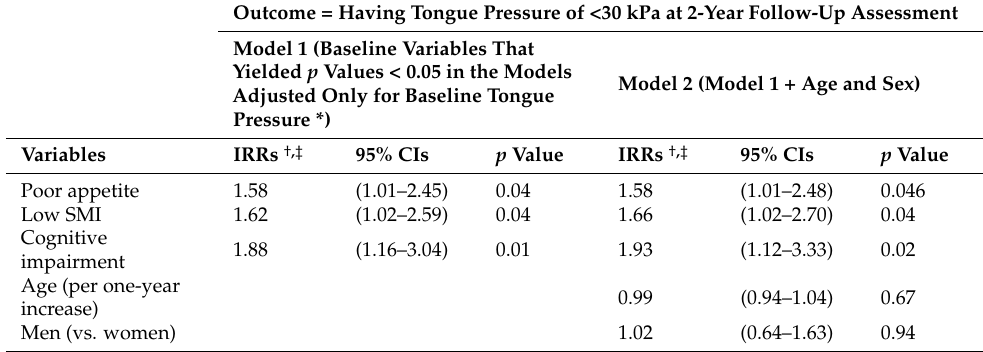
CI, confidence interval; IRR, incidence rate ratio; SMI, skeletal muscle mass index. * Candidate baseline variables are presented in Table 2. † Applying inverse probability weighting. ‡ Adjusting for baseline tongue